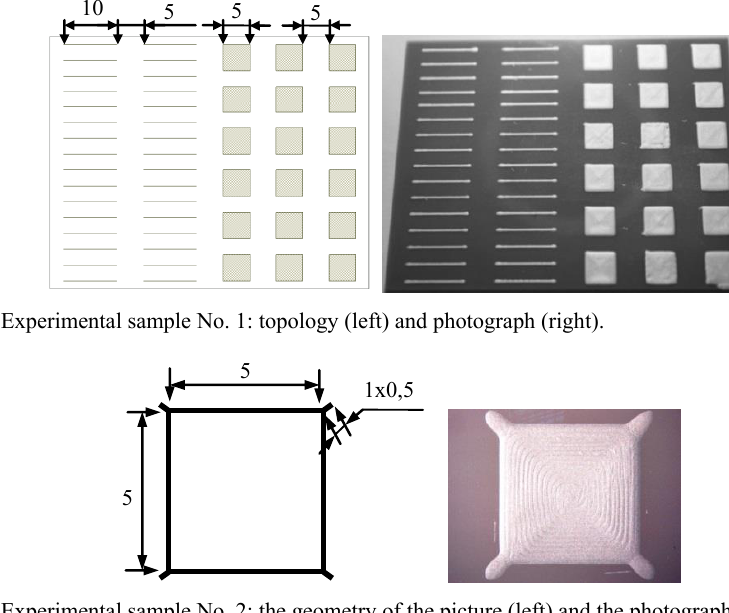
Fig. 3. Experimental sample No. 2: the geometry of the picture (left) and the photograph (right).